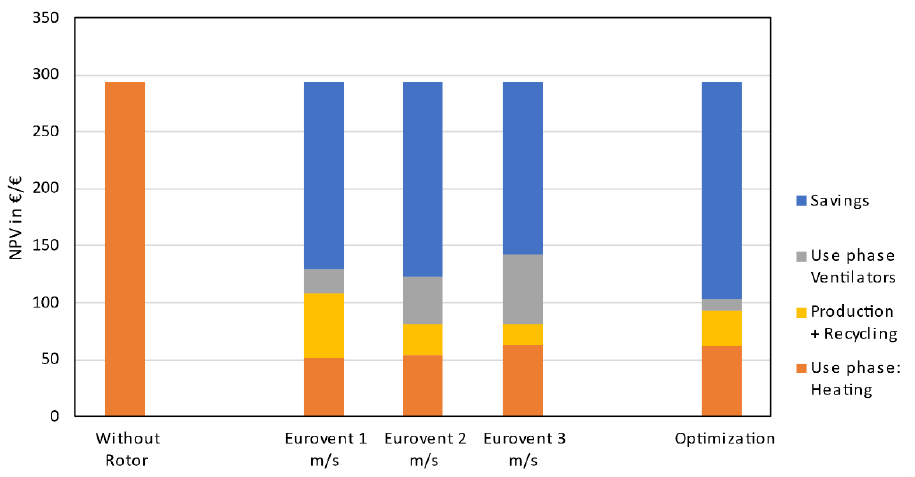
Figure A2. 25 €/t CO 2 Eq. scenario with optimized RHX and Eurovent RHX under different operating ambient air empty tube velocities at 100,000 m 3 /h.